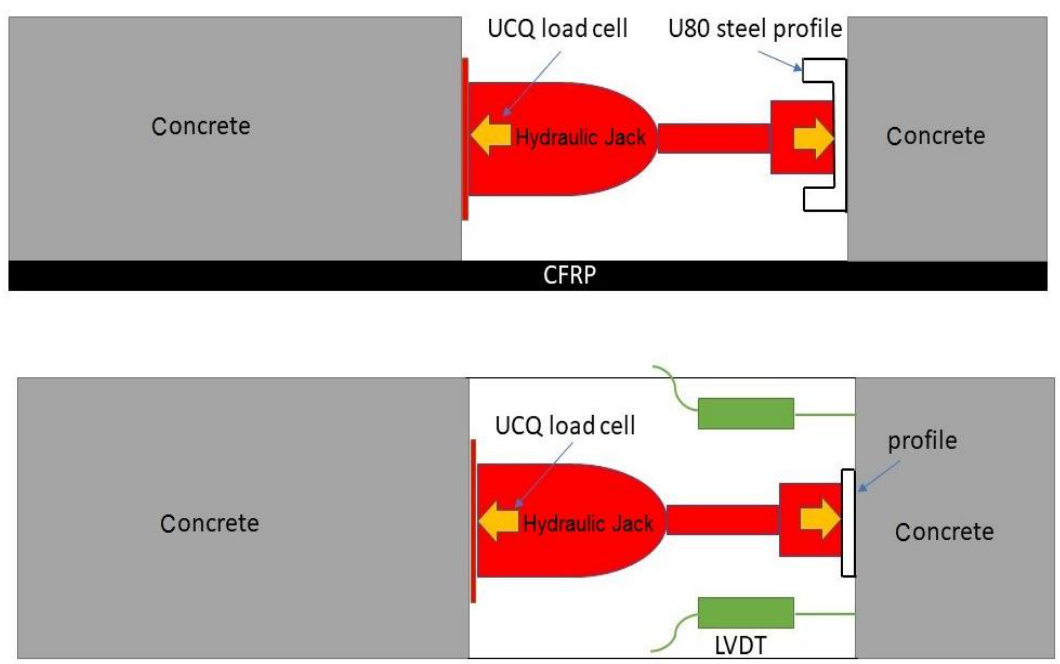
Figure 4. Test setup and instrumentation. Side view and top view.